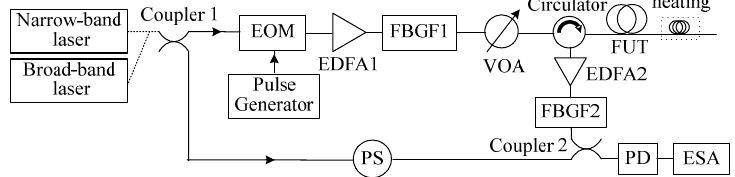
Figure 5. Experimental setup of temperature sensing based on the local heterodyne detection BOTDR